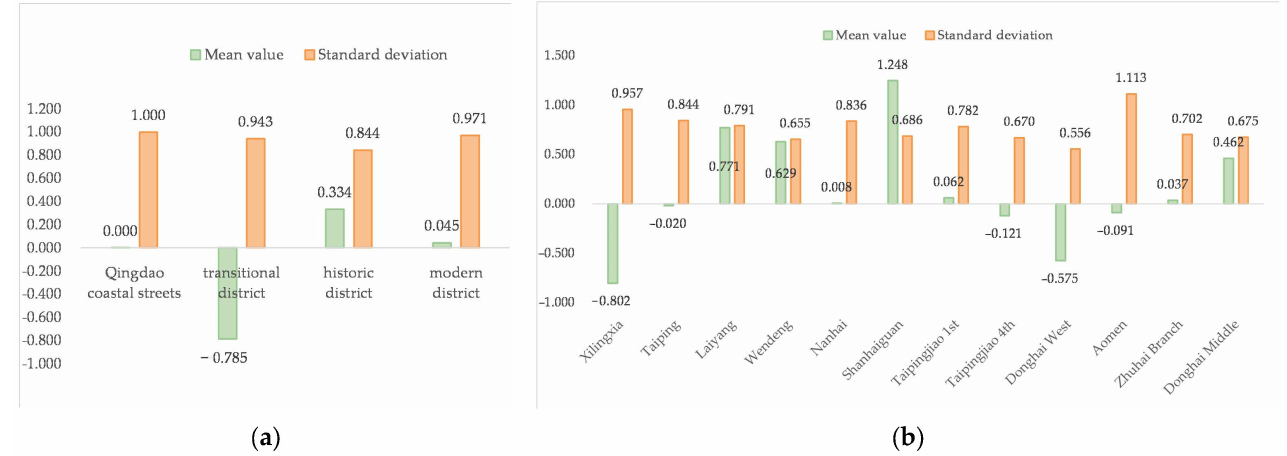
Figure 9. ( a ) The descriptive analysis of VICO values in the overall Qingdao Coastal Streets and the three types of districts; ( b ) the descriptive analysis of VICO values in the 12